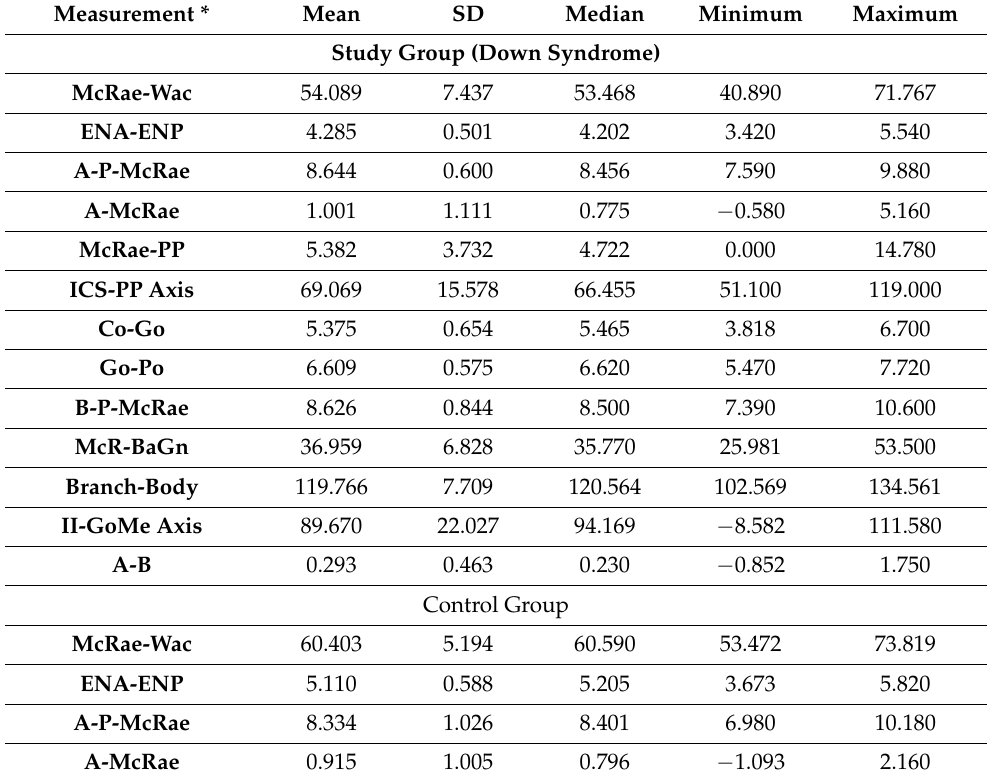
Table 3. Cephalometric Measurements in the Study (Down Syndrome) and Control